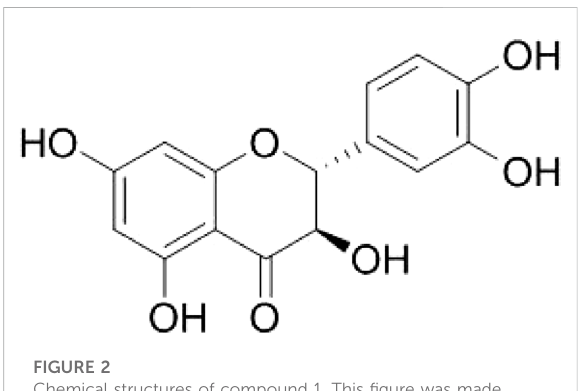
Chemical structures of compound 1. This fi gure was made with ChemDraw (http://www.perkinelmer.com/category/